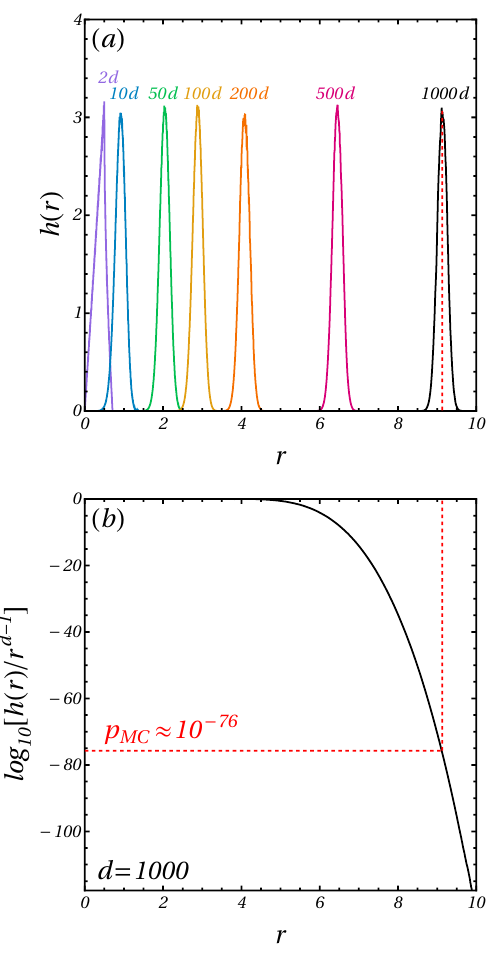
Figure 7: Mass distribution estimate. ( a ) Mass dis- tribution of the unit-sidelength hypercube, a = 0 . 5, as estimated from MBAR, using the same runs as in Fig. 6, in d = 2 , 10 , 50 , 100 , 200 , 500 , 1000 dimensions. ( b ) Decimal log of the ratio between the mass distribu- tion and that of the smallest ball containing the whole cube for d = 1000. The dashed red lines indicates the (cid:112) d/ 3 a of the maximum for d = 1000, and the location value of the ratio it corresponds to in ( b ). We indicate the probability p MC of landing a single point inside the cube when drawing points uniformly from that specific hyperspherical